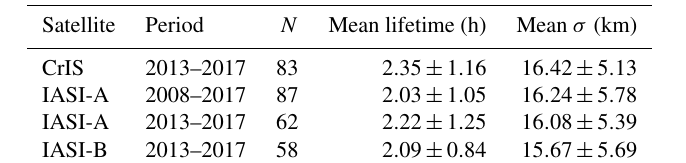
Table 3. Mean lifetime and σ for all successful fits with a correlation > 0.5 and a SNR > 2 for the 5-year IASI-A, IASI-B and CrIS and 10-year IASI-A datasets.